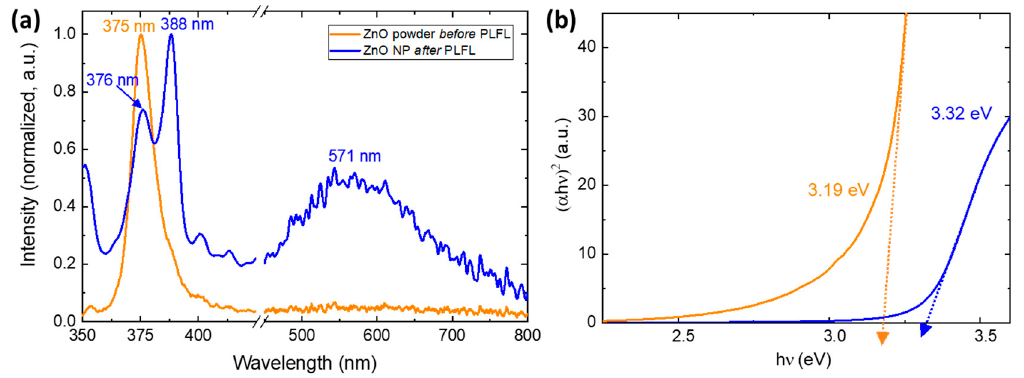
Figure 4. ( a ) Photoluminescence spectra and ( b ) Tauc plots for the ZnO nanoparticles both before (orange lines) and after (blue lines) PLFL processing.